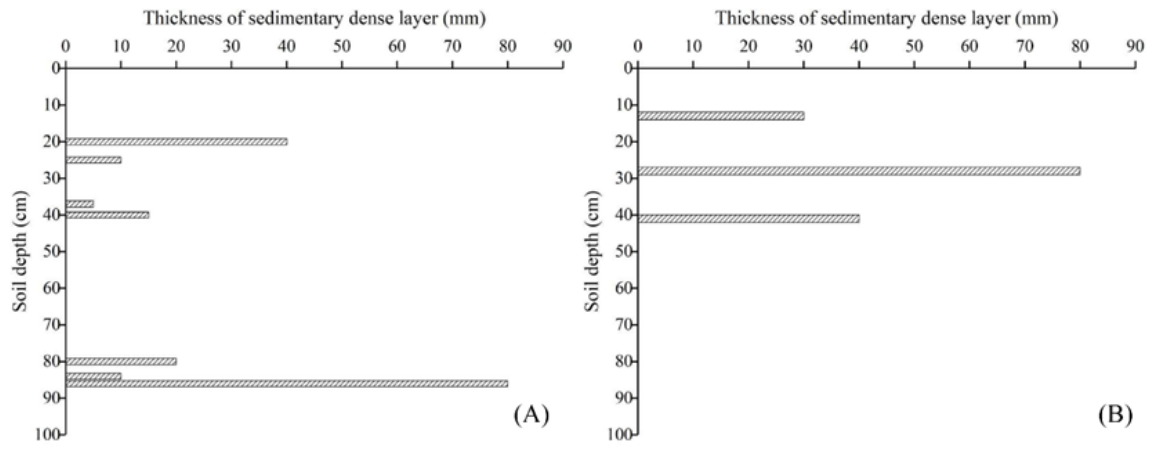
Figure 6. The vertical distribution of the sedimentary dense layer. ( A ) is the distribution of silted dense layer in the first silted dense layer infiltration test, ( B ) is the distribution of silted dense layer in the second silted dense layer infiltration test. Table 2. Initial soil water